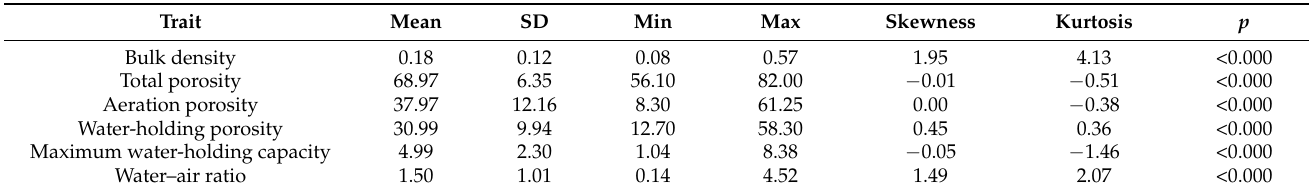
Table 2. Analysis of variance of physical properties of mixed substrates.